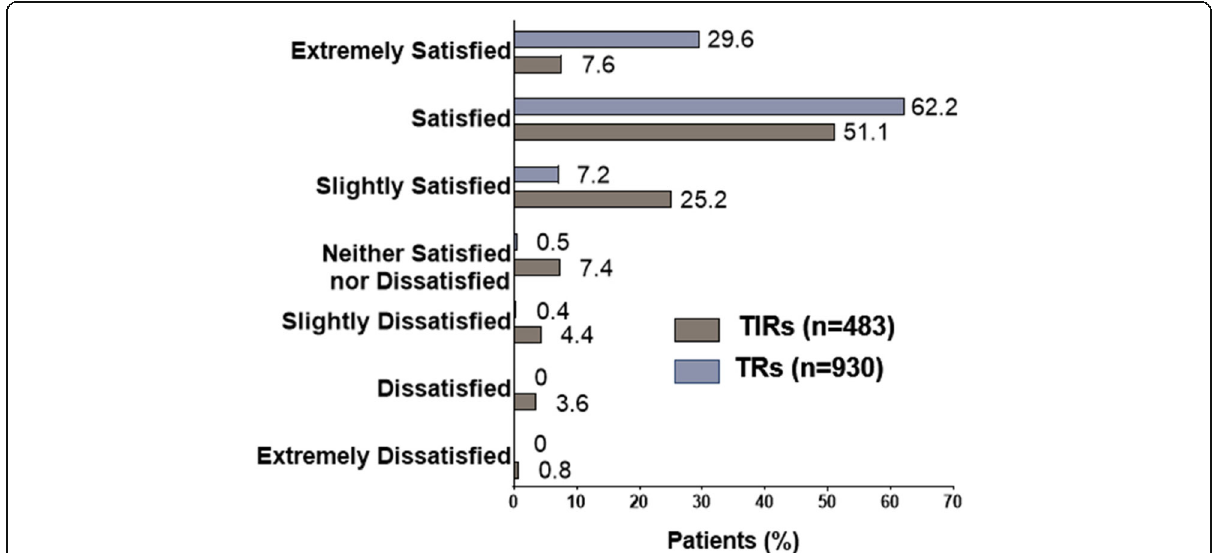
Fig. 2 Patient-reported satisfaction with acute medication. Note: p < 0.001 overall for TIRs versus TRs using Fisher ’ s exact test. TIR = triptan insufficient responder; TR = triptan